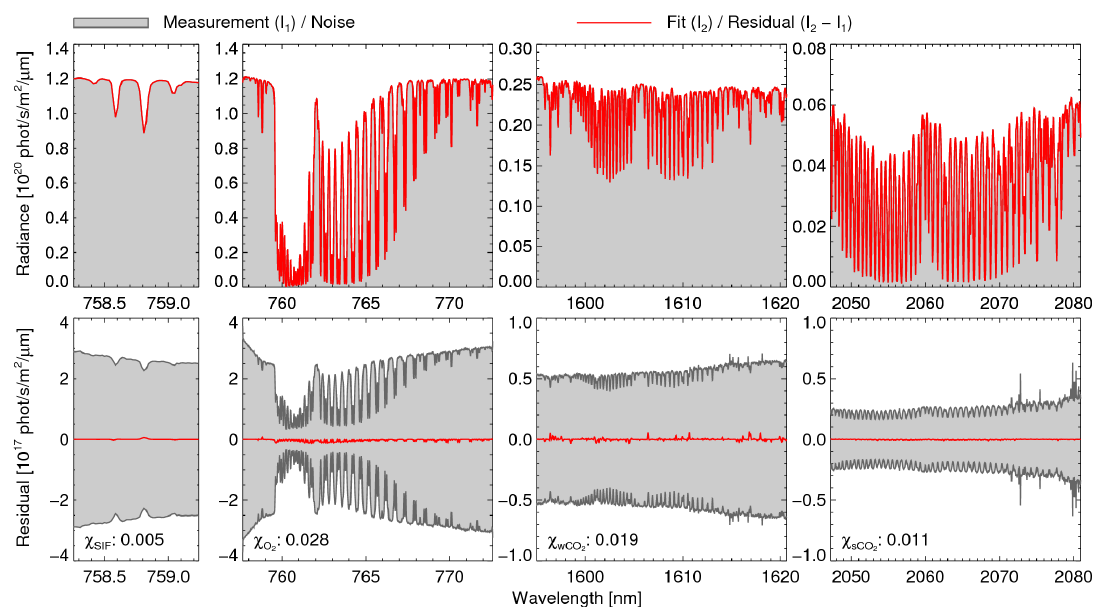
Figure 3. SCIATRAN simulated OCO-2 measurement fitted with FOCAL. Geophysical baseline scenario and 0-Scat retrieval setup, θ 0 = 40°, parallel polarization. See Section3.2 for definitions of geophysical scenarios and retrieval setups. Top : Simulated and fitted radiance measurement in gray and red, respectively. Bottom : Simulated measurement noise and fit residual (cid:126) ∆ y = (cid:126) I 2 − (cid:126) I 1 (fit minus measurement) in gray and red, respectively. An estimate of the goodness of fit (relative to the noise) in (cid:126) ∆ y T (cid:126) ∆ y ) 1/2 S − 1 (cid:101) fit window j is computed by χ j = ( 1 j j m j j